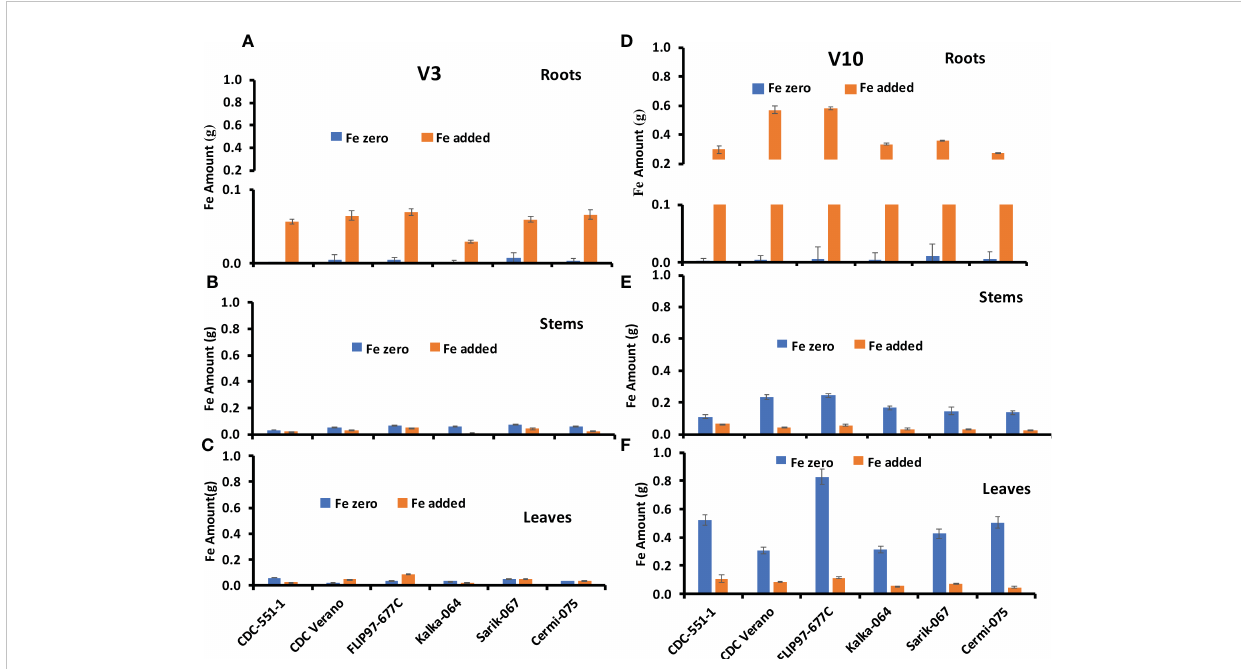
FIGURE 3 Mean Fe amount (g, ± SE, n = 48) at V3 and mean Fe amount (g, ± SE, n = 24) at V10 growth stages in roots (A, D) , stems (B, E) , and leaves (C, F) , of six different genotypes of chickpea under Fe zero and Fe added